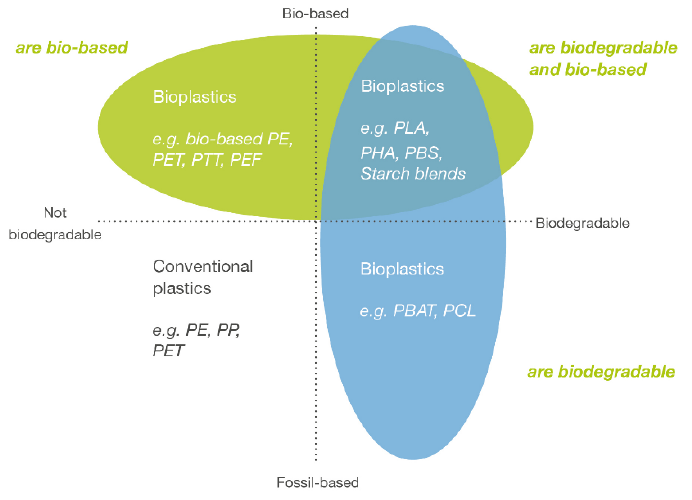
Figure 1. Material coordinate system of bioplastics [8].